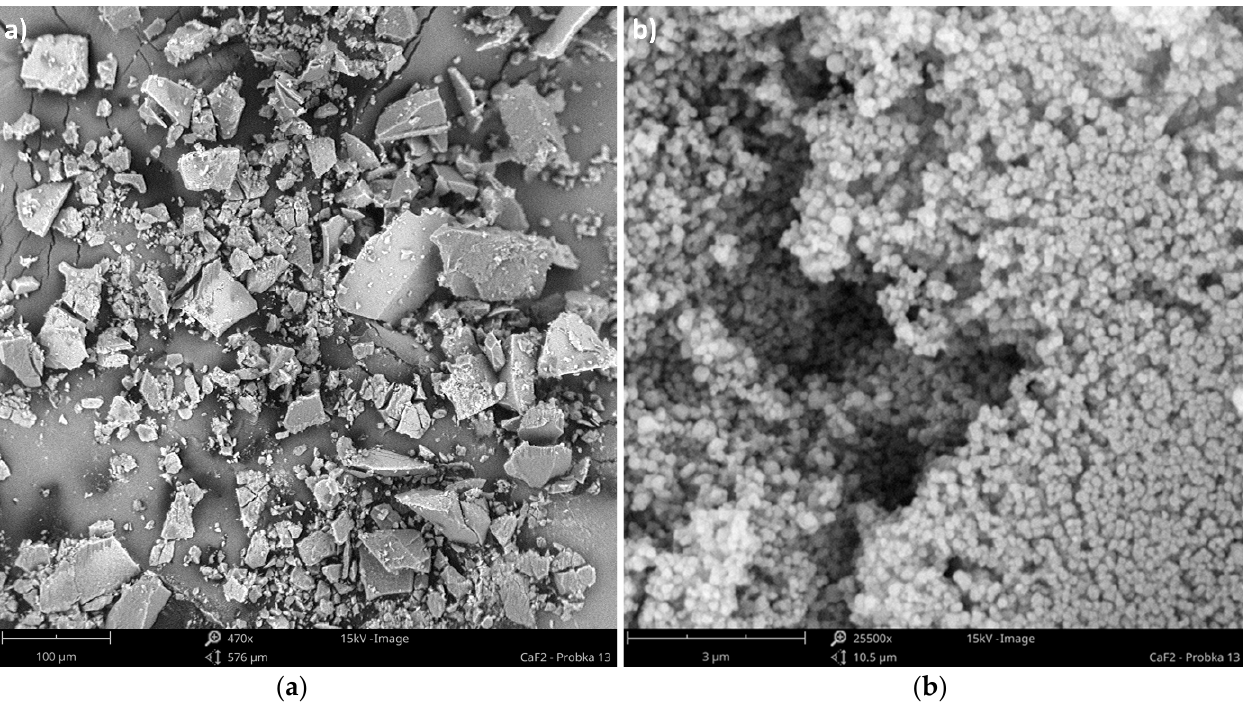
Figure 1. SEM images of CaF 2 particles precipitated in the Koflo static mixer—silent conditions. Operating conditions: ε mix = 4.9 W/kg, Re eqv = 3994; ( a ) magnification 470×, size bare: 100 μ m; ( b ) magnification 25,500×, size bare: 3 μ m.